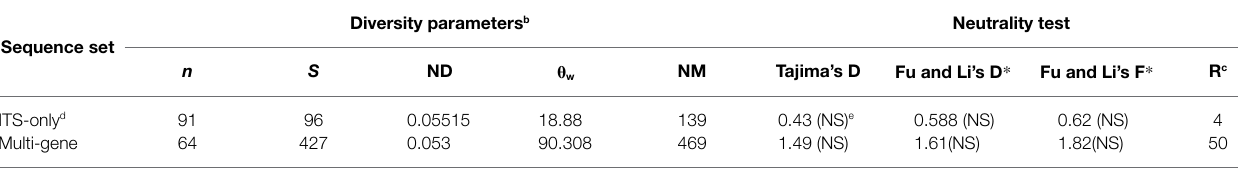
Diversity parameters